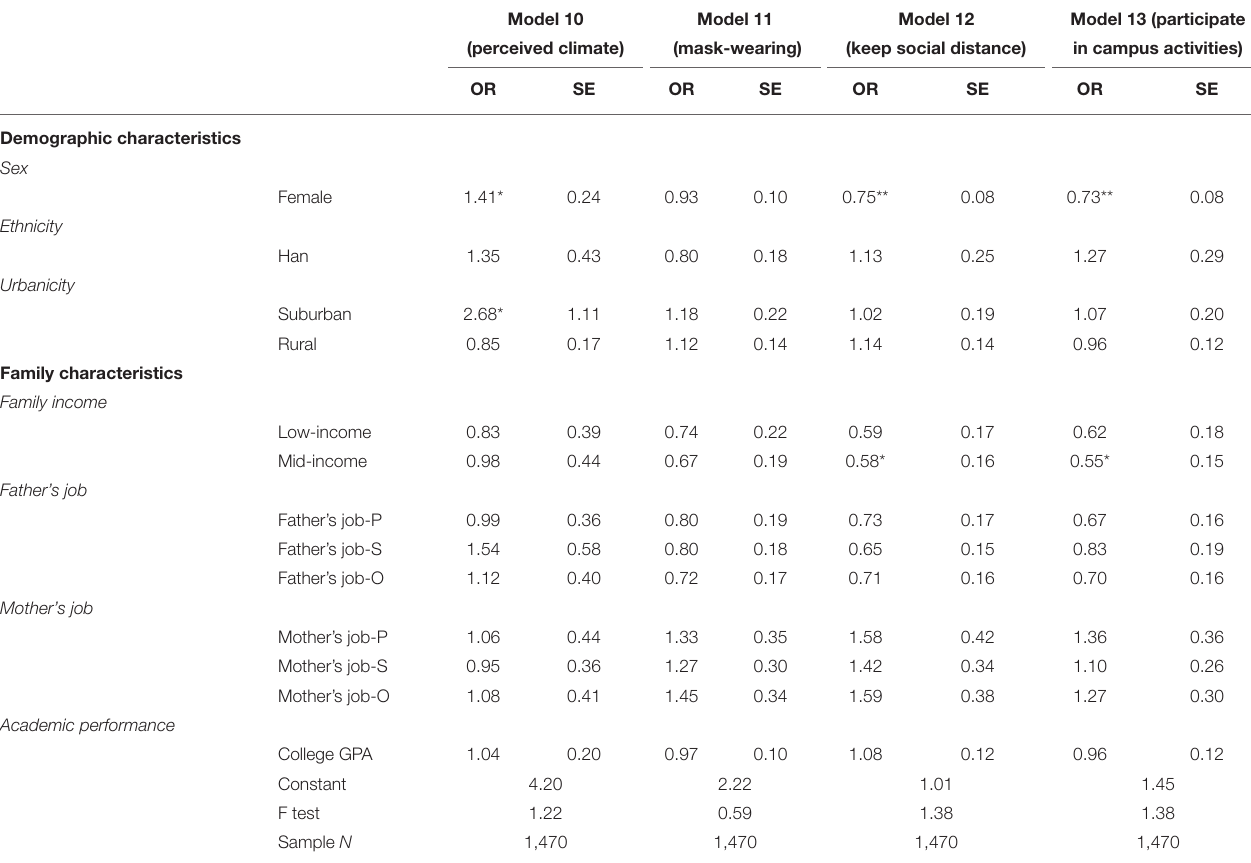
TABLE 6 | The relationships between family characteristics and students’ responses to campus climate